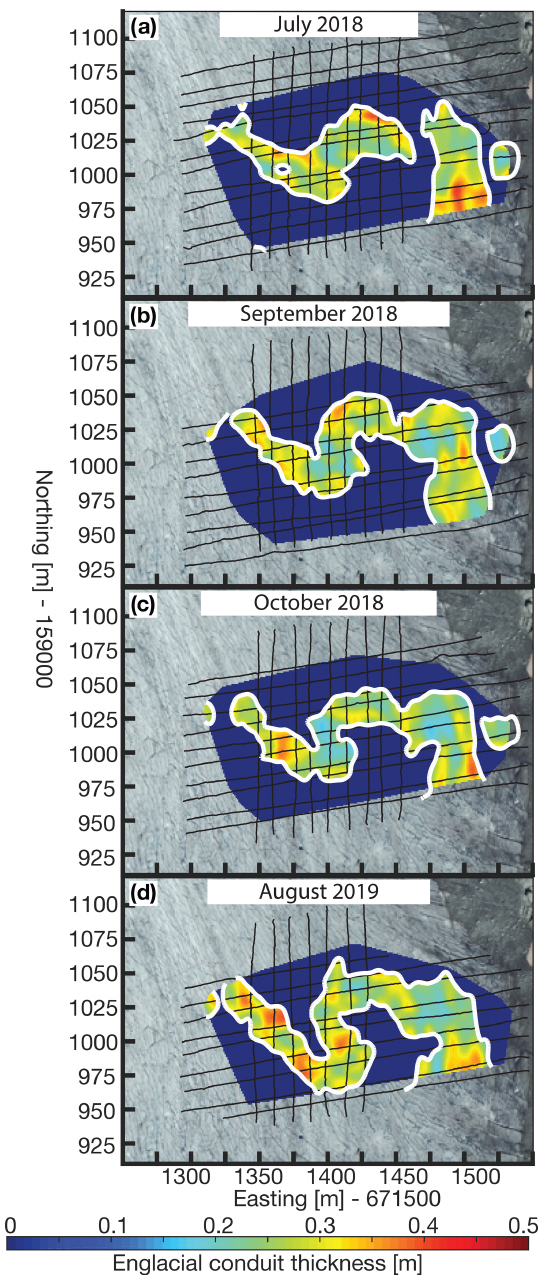
Figure 6. Estimated englacial conduit thickness during the summer months of (a–c) 2018 and (d) 2019. The white contour represents the englacial conduit reflectivity at − 0 . 1, the same contour as dis- played in Fig.